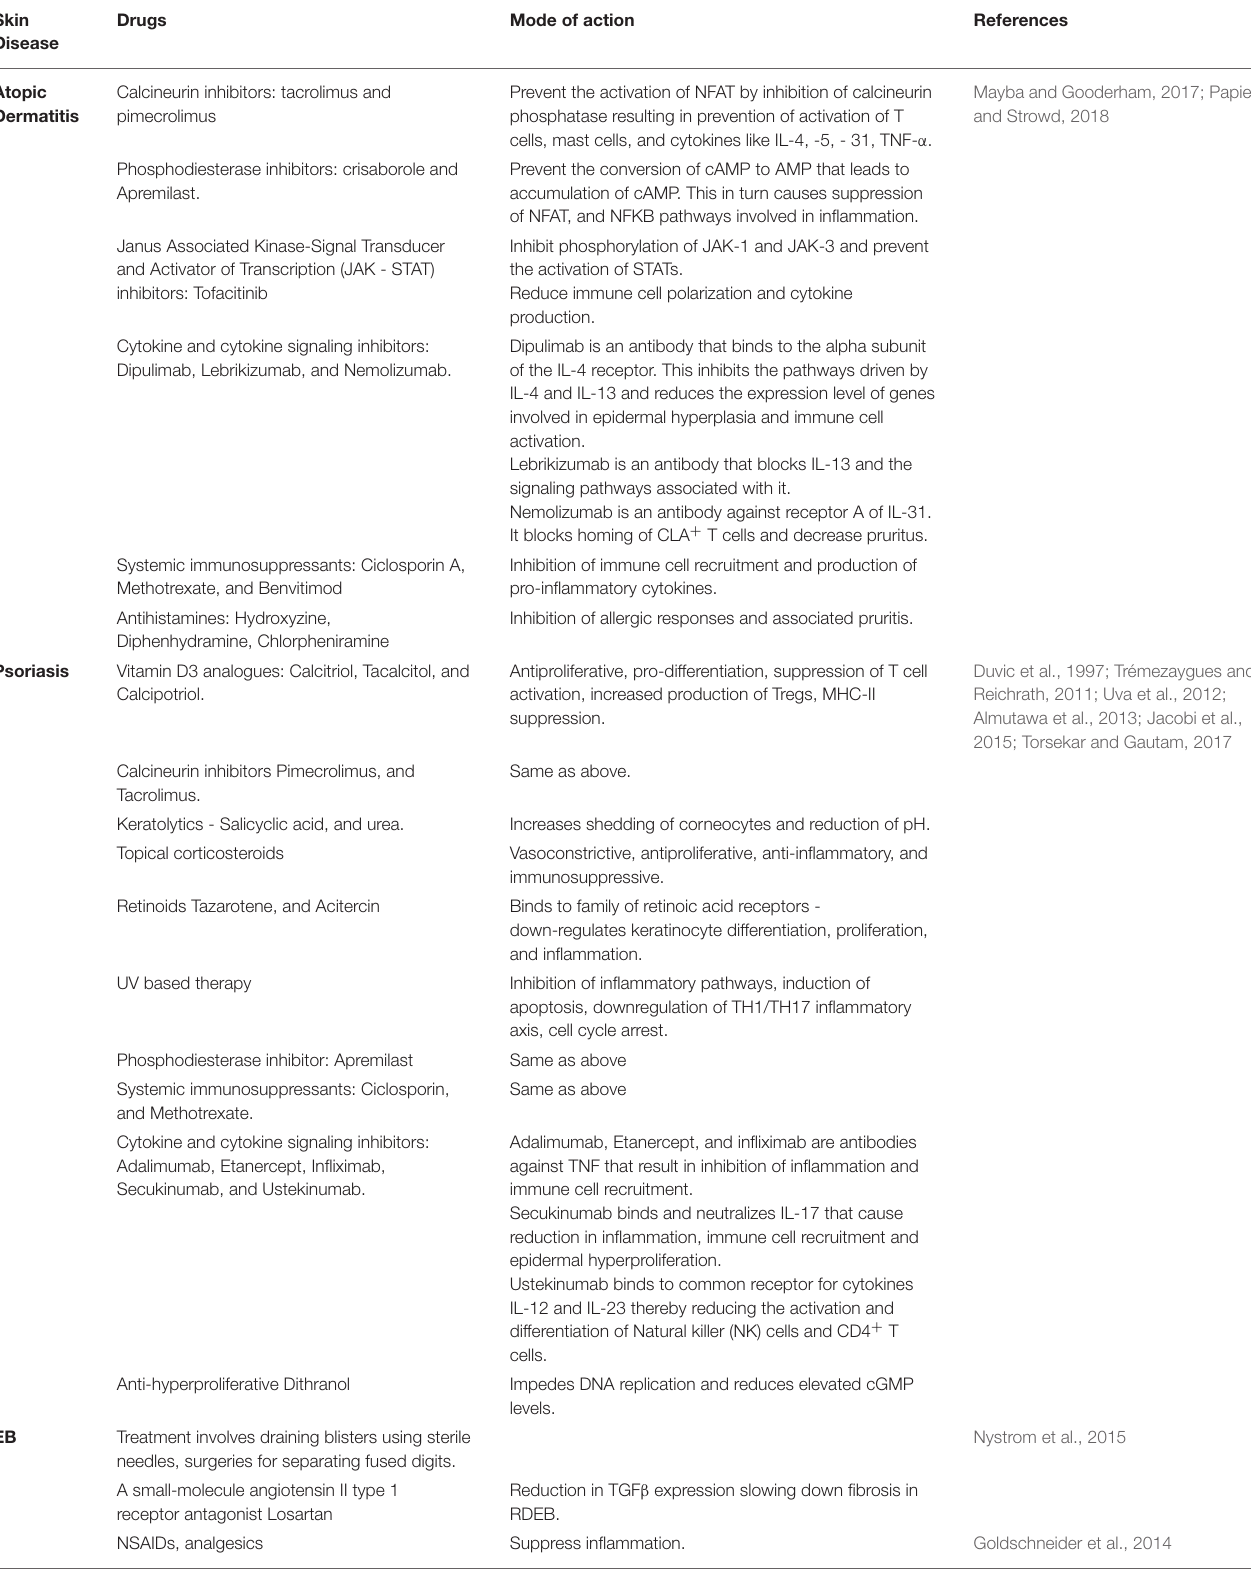
TABLE 3 | Conventional treatment strategies. Skin